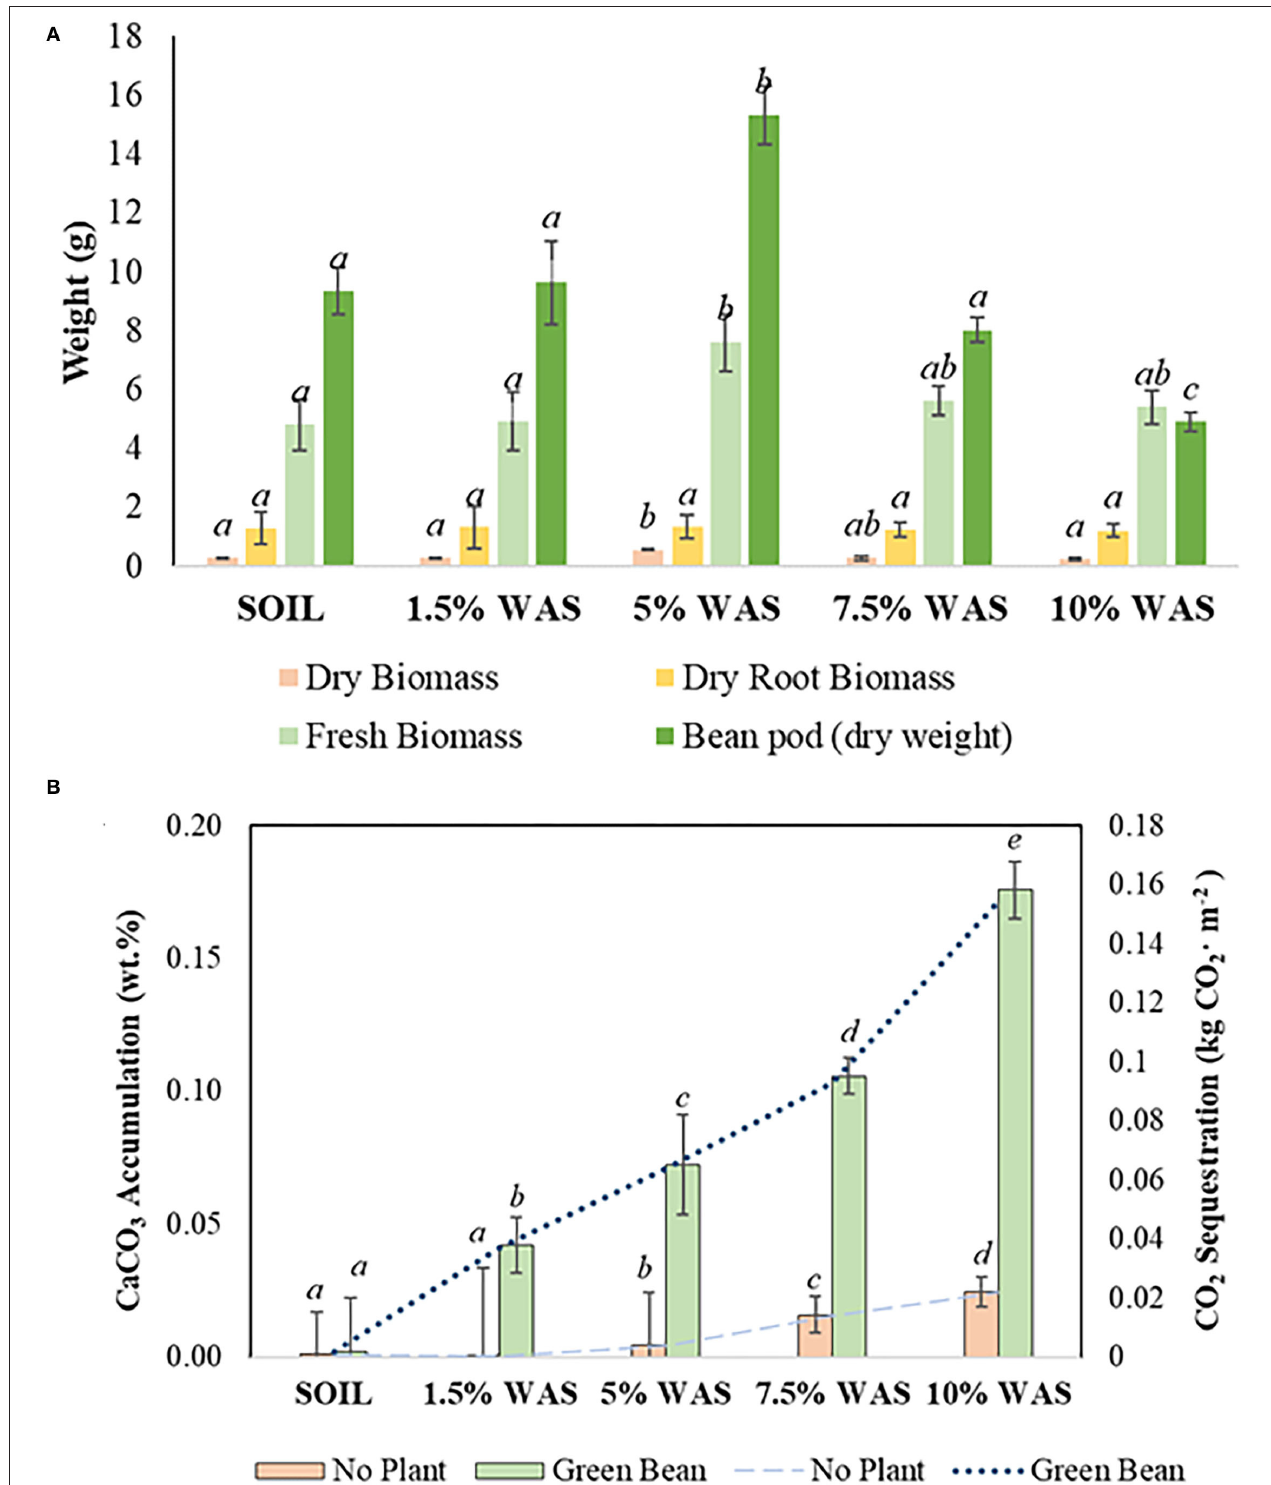
FIGURE 2 | (A) Variation in the green bean fresh and dry biomass ( n = 15), dry root biomass ( n = 15), and pods (analyzed per subplot of five plants) at different doses (wt.% in soil) of wollastonite skarn soil amendment; (B) Pedogenic carbonate accumulation (bars) and CO 2 sequestration (lines) in the various microplots. Lowercase letters (a–e) indicate significant differences between treatments ( p <